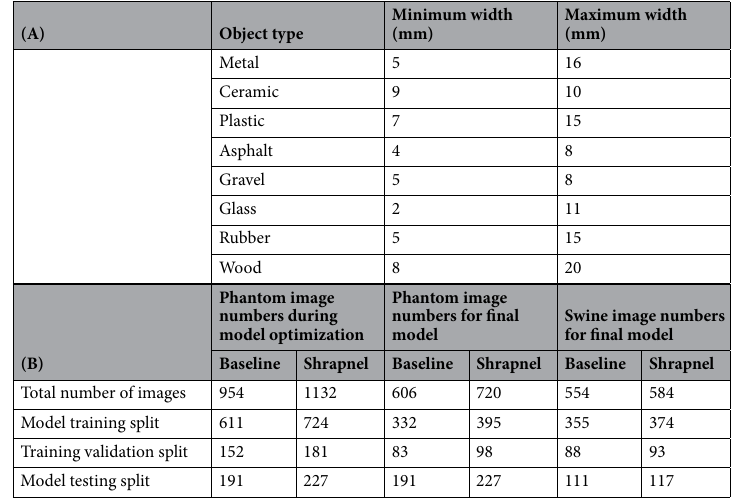
Table 1. Overview of shrapnel types used and total number of images for training, validation, and testing. (A) Shrapnel were irregularly shaped, so the approximate longest and shortest width of the objects are reported. All objects were hyperechoic relative to the phantom or swine tissue. (B) Images were randomly distributed between each group for both baseline and shrapnel image classification. The process was repeated for all phantom images, all swine images, and a subset of the phantom images to be more similar in number to the swine image sets for consistency during final model